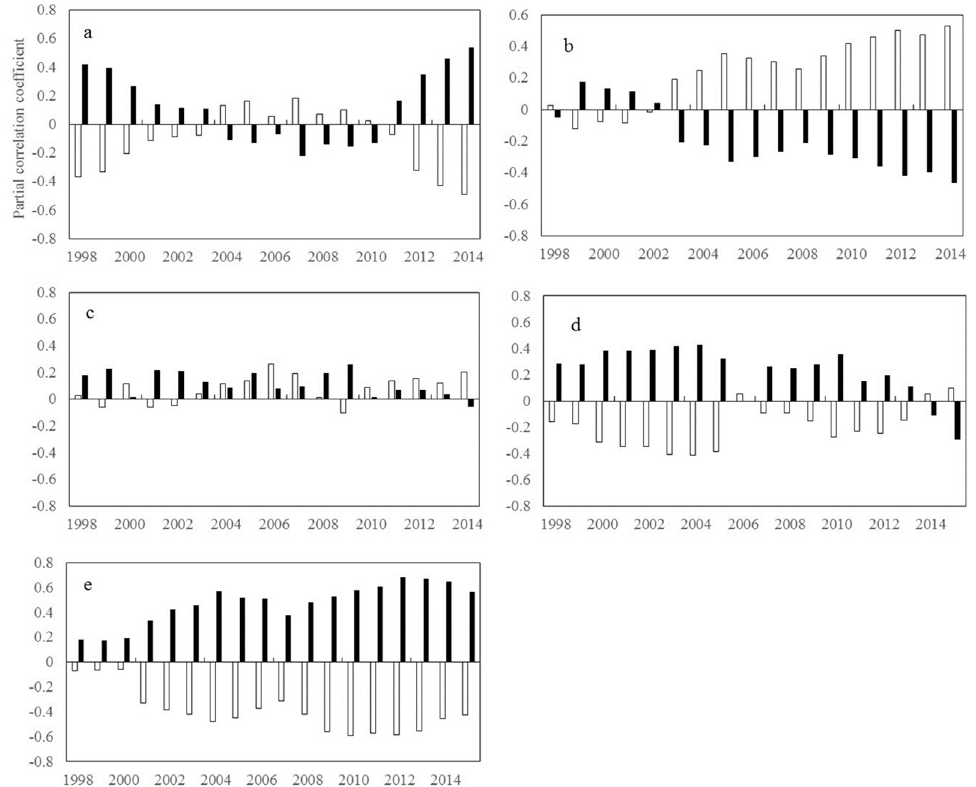
Figure 5. Temporal variations in the partial correlation coefficients between mean NDVI and the diurnal temperature (T max and T min ) in winter for each 17-year moving window across latitudes intervals. ( a – e represents latitudes intervals at 60 ◦ ~90 ◦ N, 30 ◦ ~60 ◦ N, 0 ◦ ~30 ◦ N, − 30 ◦ ~0 ◦ S, and − 60 ◦ ~0 ◦ S, respectively (N and S indicates the Northern and southern hemisphere, respectively). The x axis is the last year of the 17-year moving-window (for example, 1998 stands for a moving-window from 1982 to 1998, . . . , 2015 stands for a moving-window from 1999 to 2015). The Y axis is the partial correlation coefficients.).